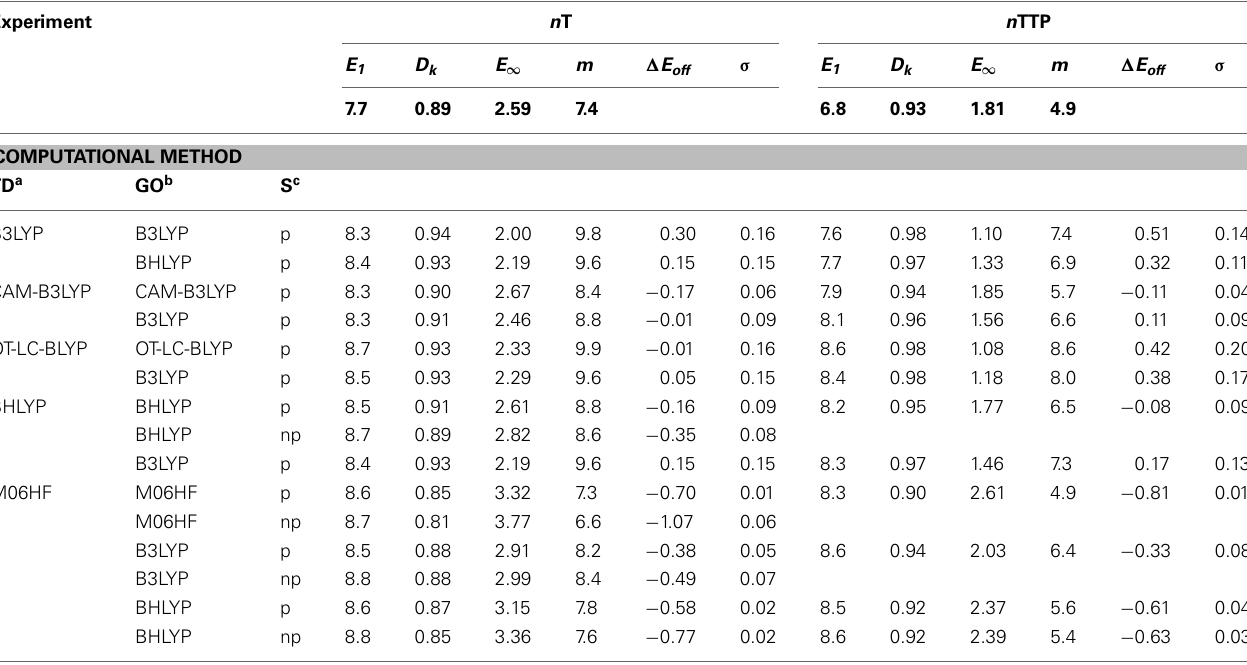
Table 1 | Kuhn fit parameters E 1 (ineV) and D K extracted from the experimental and computed E vert as given in Figure 6.